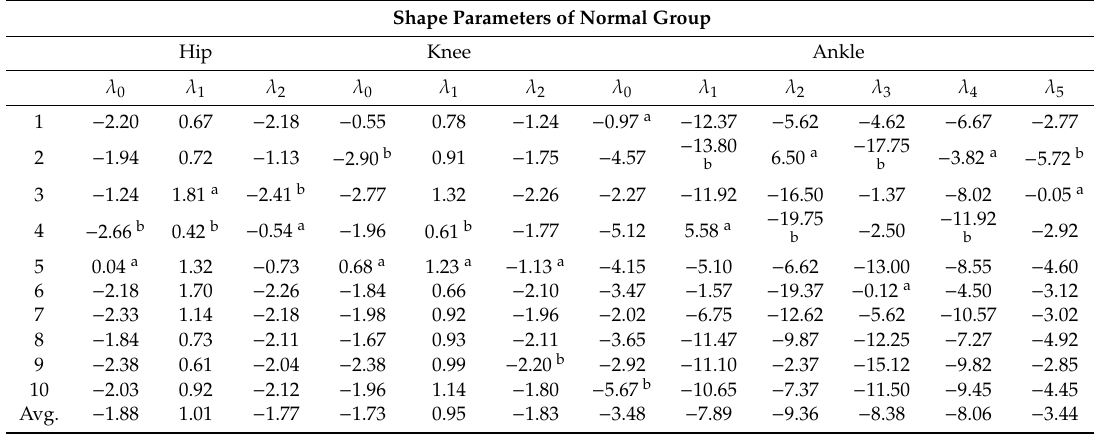
Table 3. Shape parameters of the normal group of three joints.